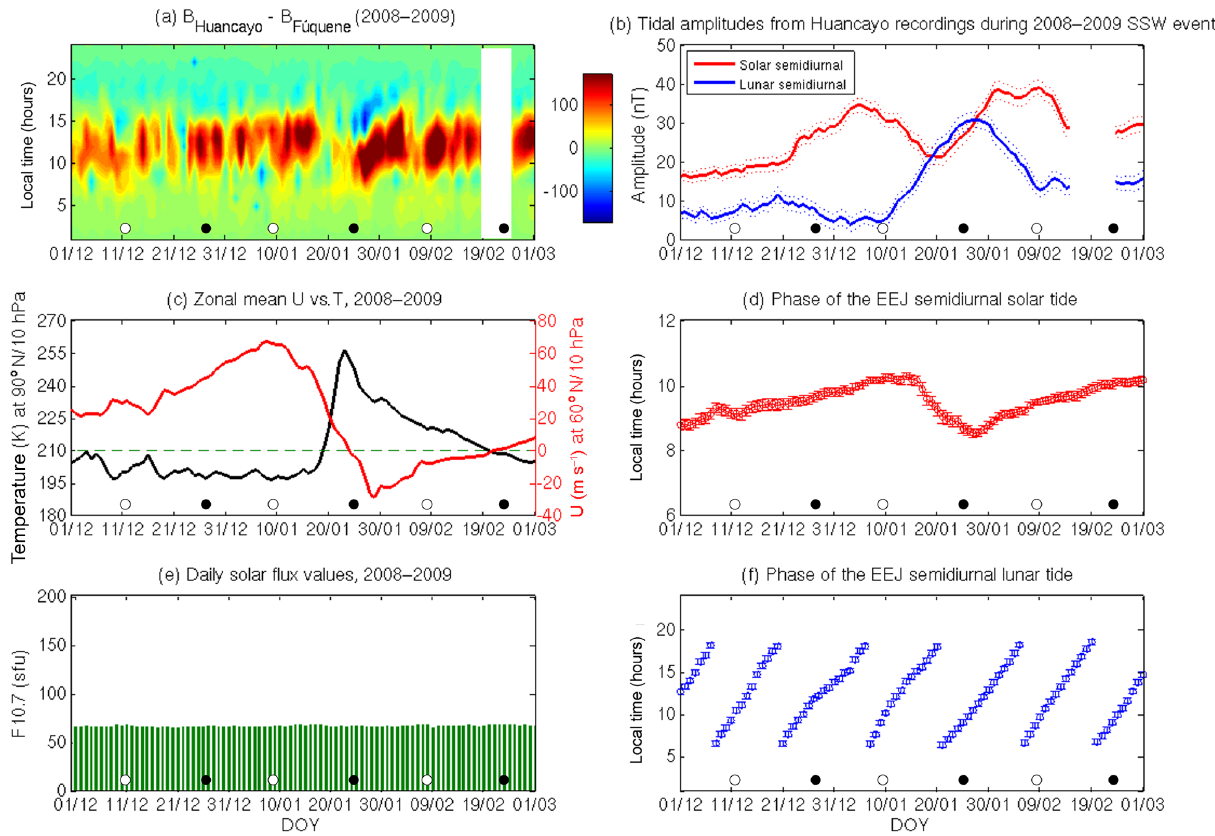
Figure 4. Same as Fig. 2, except between 1 December 2008 and 1 March 2009. The missing period of data is marked in white